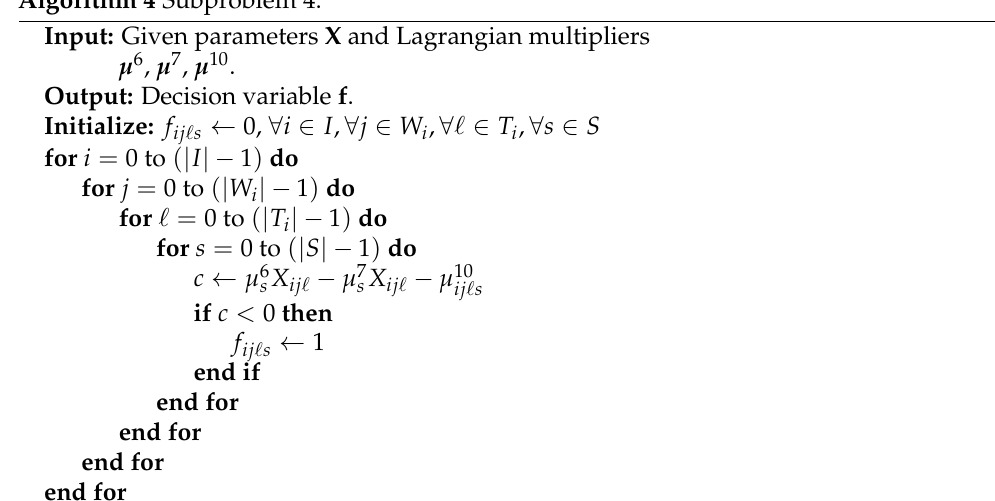
Algorithm 4 Subproblem 4.